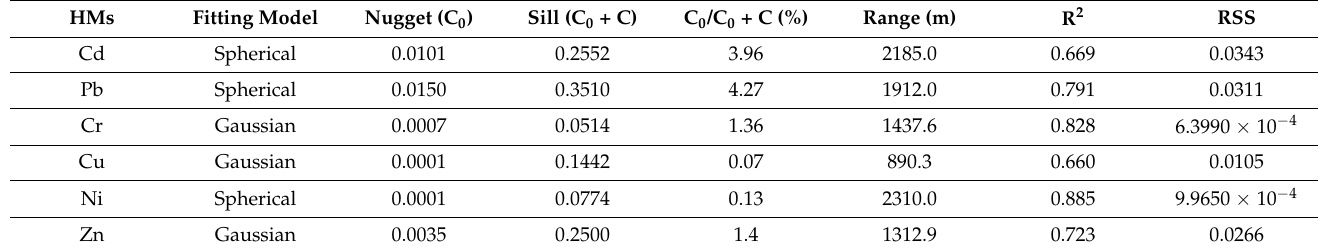
Table 5. Semivariance models and corresponding correlation coefficients of agricultural soils